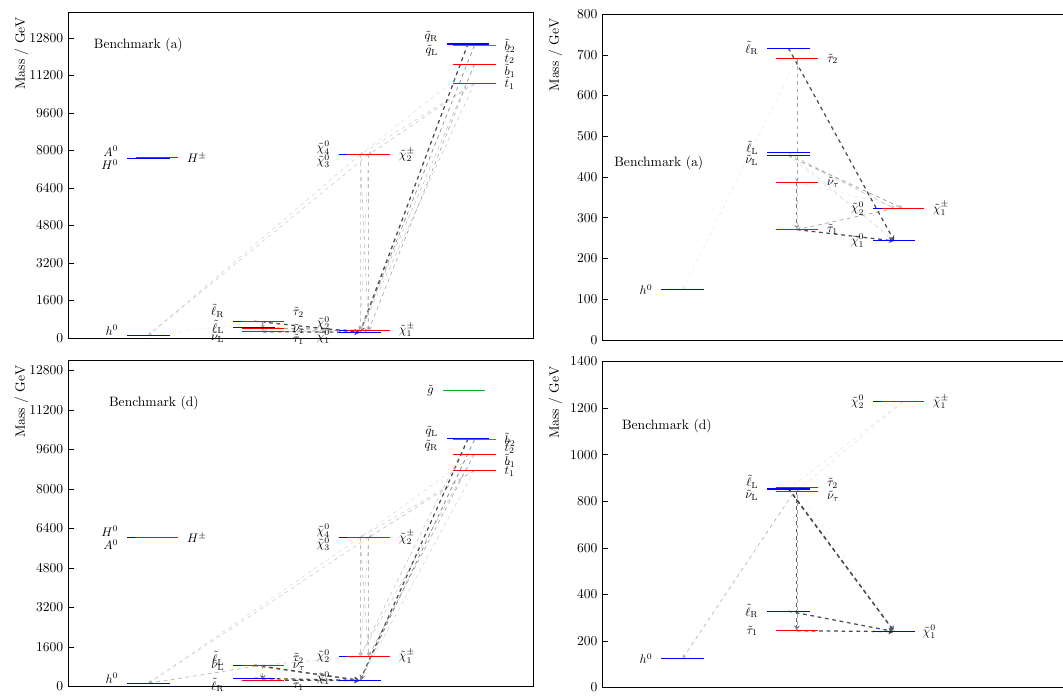
Figure 3 . A display of the particle spectrum using PySLHA [89] for benchmarks (a) (upper panels) and (d) (lower panels). The left panels represent the spectrum up to 13 TeV while the right panels give the low-lying masses of the